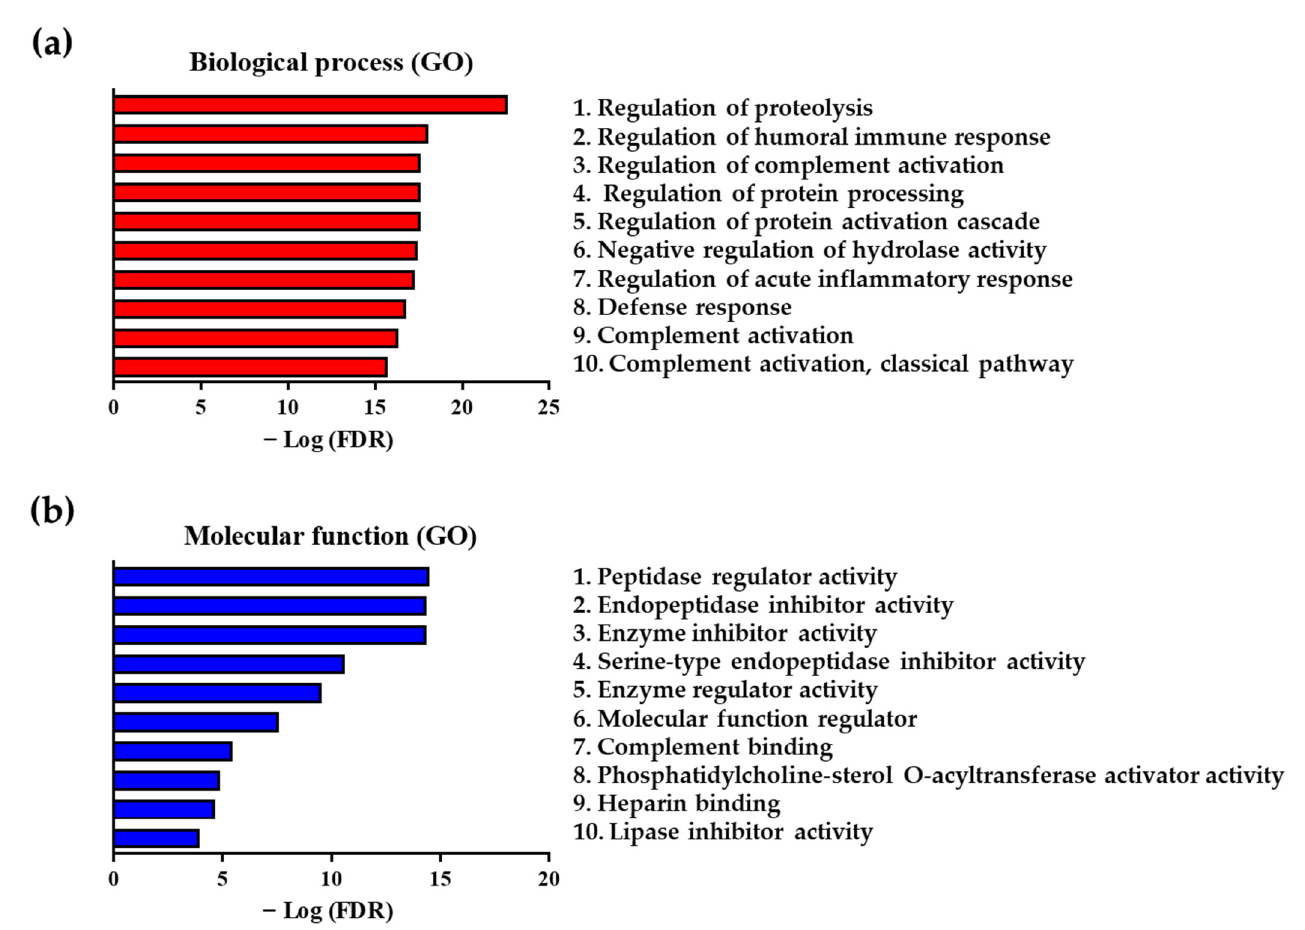
Figure 3. Functional analysis of 42 differentially expressed proteins between patients with ACS and healthy controls. ( a ) The top 10 biological processes (gene ontology; GO) and ( b ) molecular functions (GO) associated with differentially expressed proteins between patients with ACS and healthy controls.